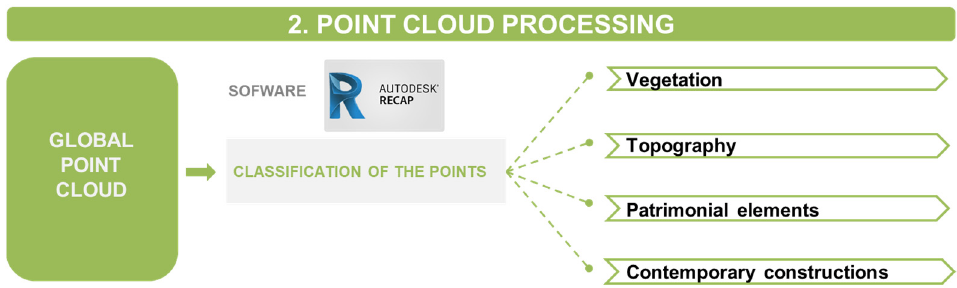
Figure 13. Workflow for further processing of the dense point cloud. The points are classified ac- cording to the nature of the points.